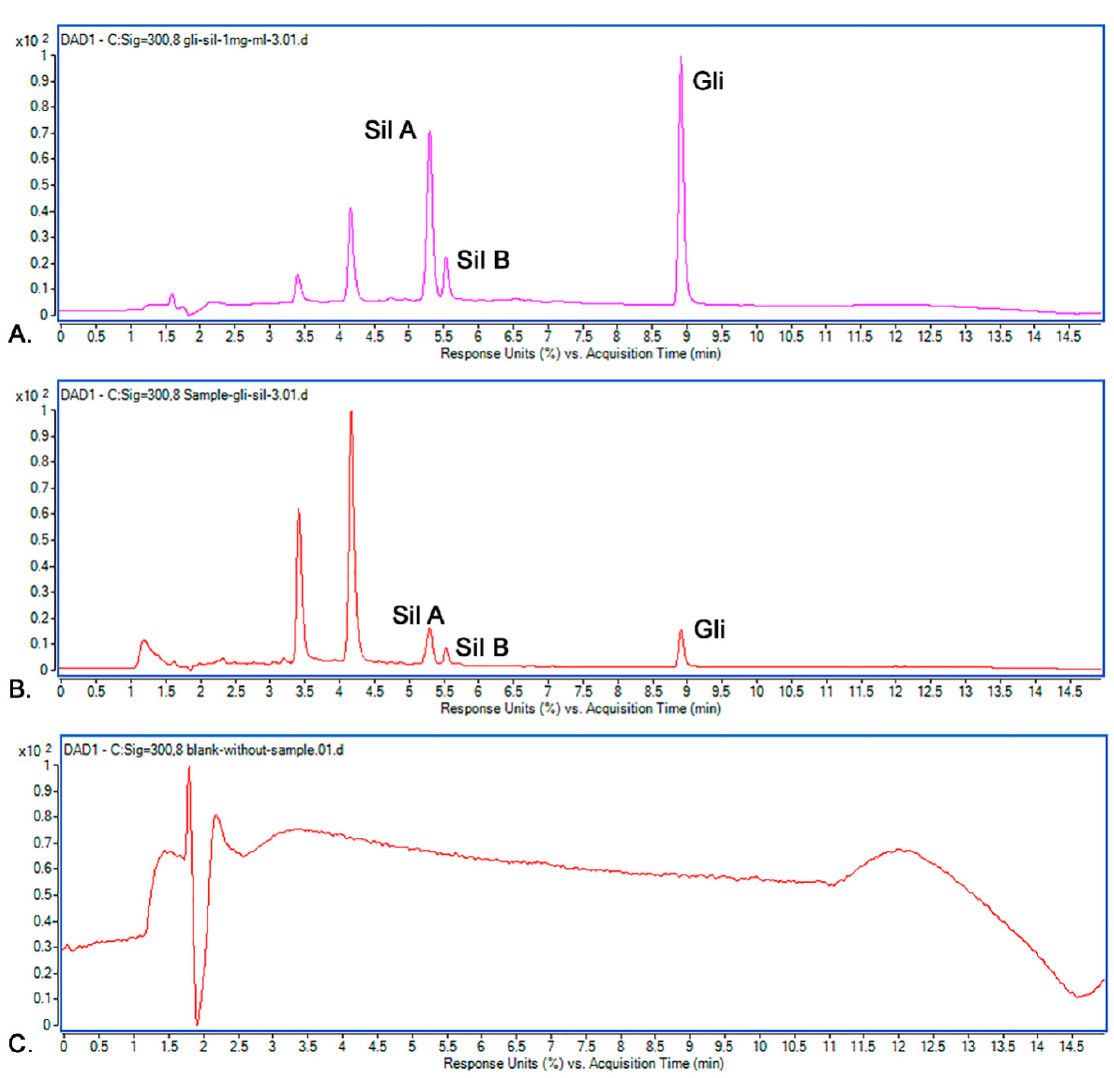
Figure 10. Chromatograms recorded: ( A ) standard solution; ( B ) sample solution; ( C ) blank solution.